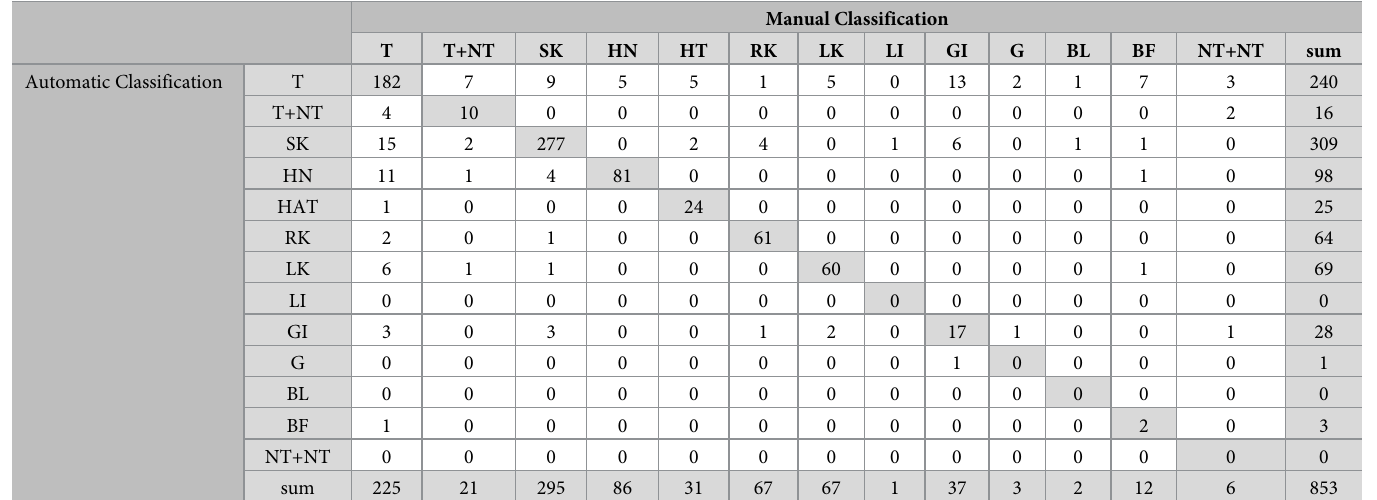
Table 2. Confusion matrix of manual and automatic classification of the segmented volumes.